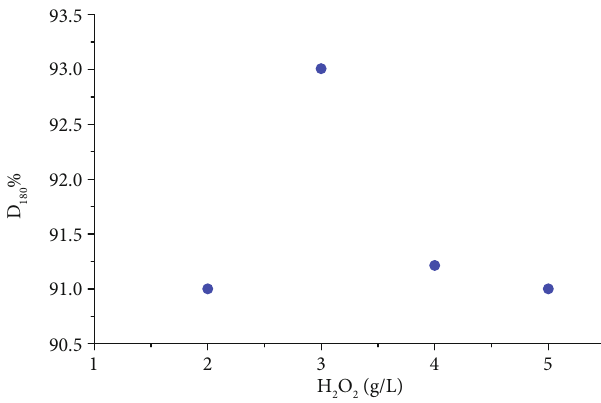
Figure 11: Catalyst dosage e ff ect over RB5 dye discoloration at %). 180min (D 180